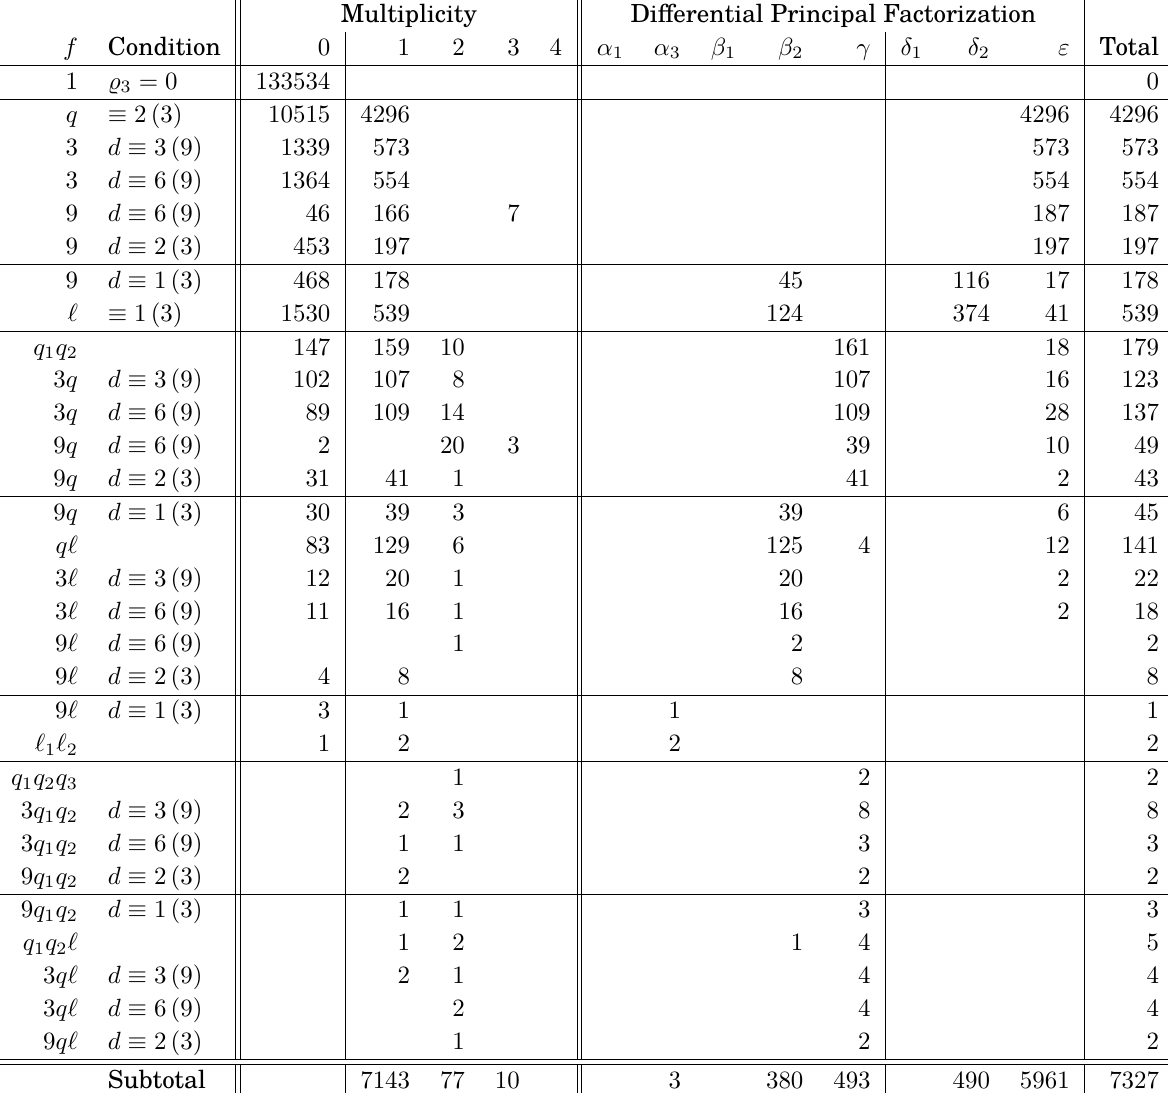
Table 10: Totally real cubic discriminants d L = f 2 · d in the range 0 < d L < 5 · 10 5 . Multiplicity Differential Principal